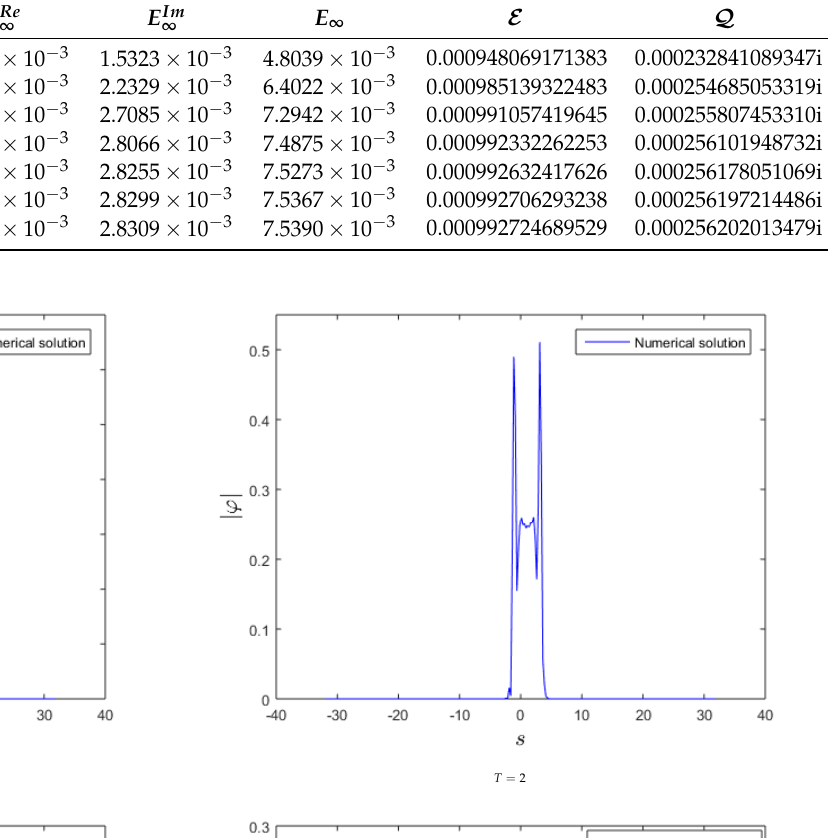
Table 7. Error norms and conservation laws at various M with T = 1 and ∆ τ = 0.01 for Test Problem 2.